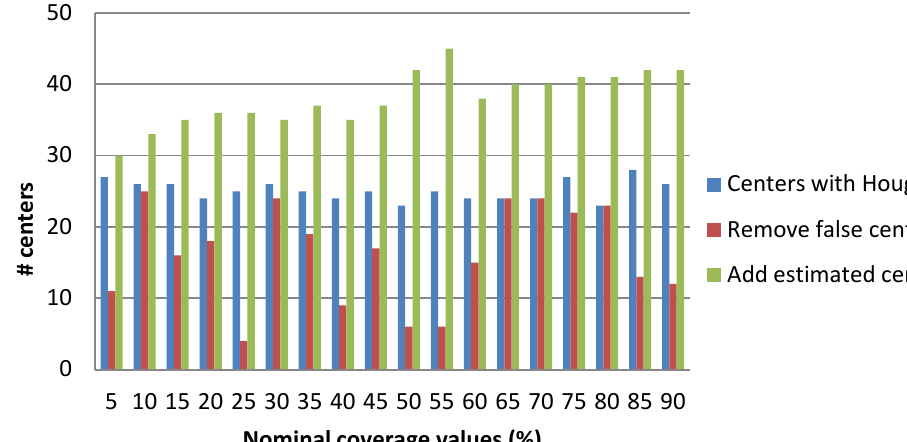
Figure 15. Number of centers obtained with Hough (blue bar), after false centers removal (red bar) and final estimation of new centers (green bar).